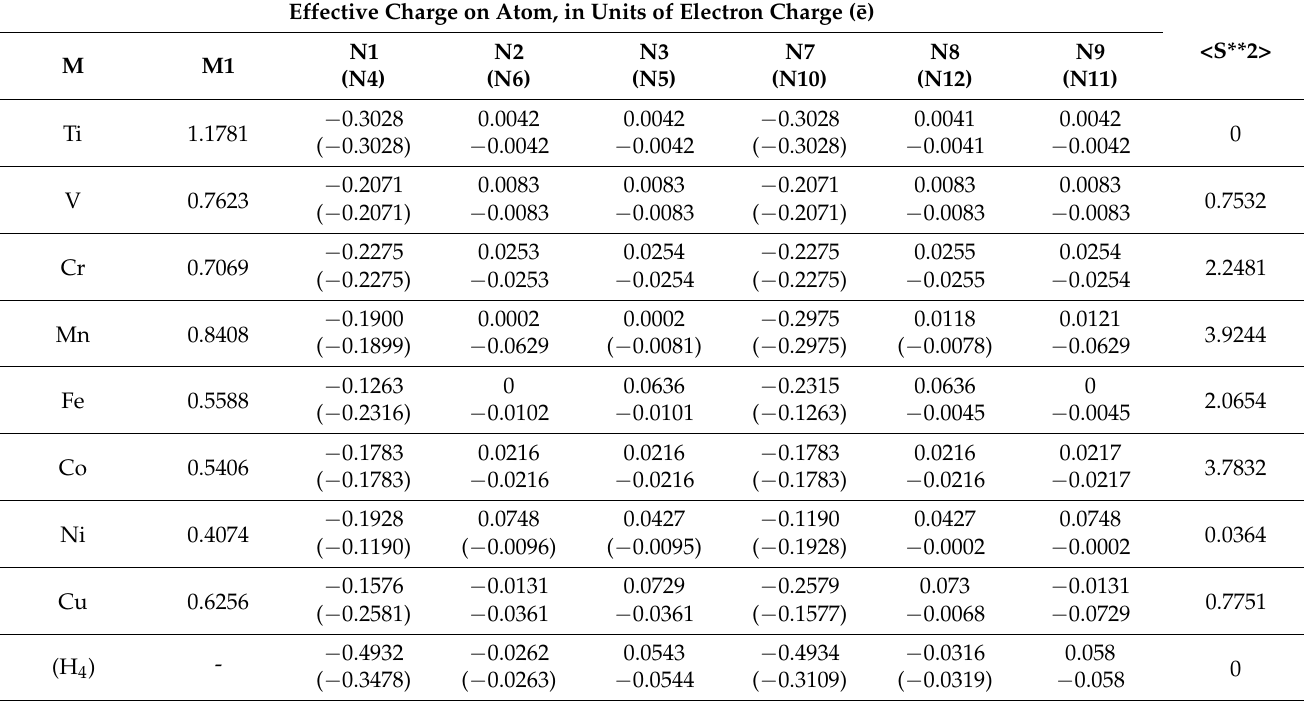
Table 3. NBO analysis data for M(N 12 ) and H 4 (N 12 ) calculated by DFT M06/TZVP method. Effective Charge on Atom, in Units of Electron Charge